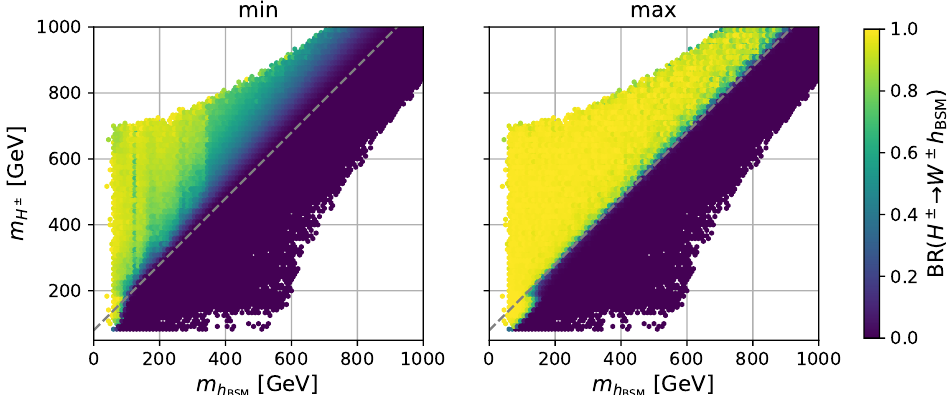
Figure 11. Branching ratio of the charged Higgs H ± into W ± h BSM in the plane of the two Higgs masses, where h denotes the non- h -even neutral Higgs boson. The left (right) BSM 125 CP plot shows the minimal (maximal) possible BR for each bin. The dashed line indicates where = m + m m h BSM W H ±